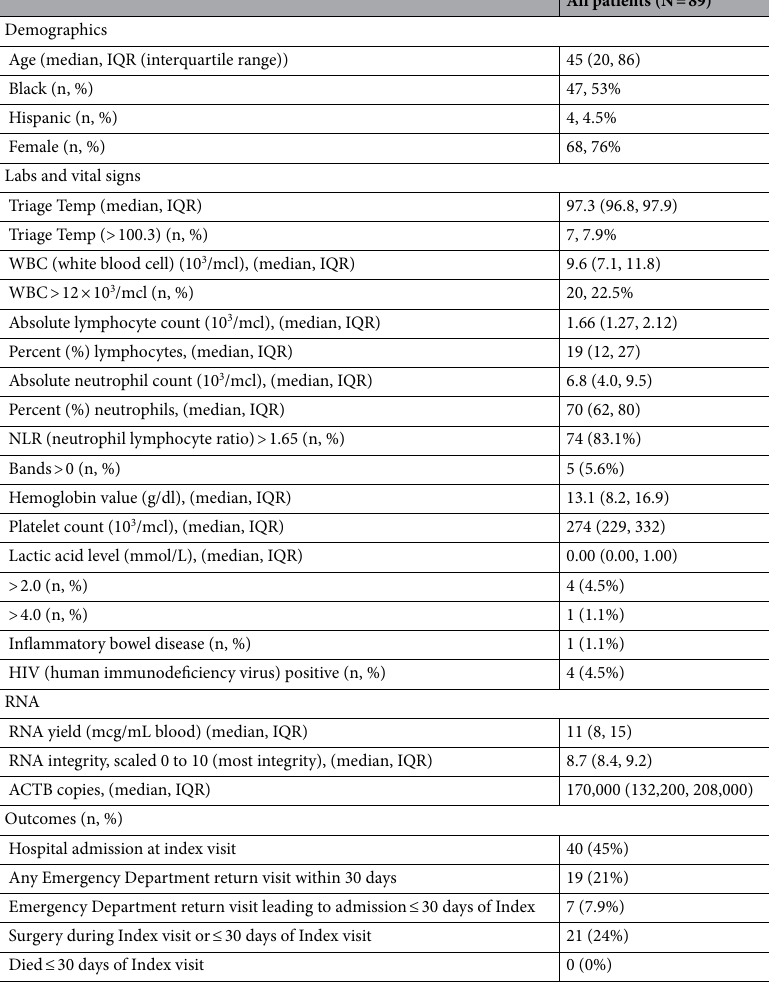
Table 1. Summary of